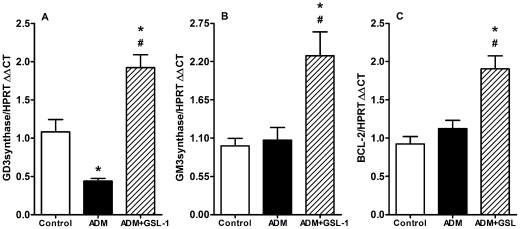
GSL-1 treatment induces transcripts for GM3 and GD3 synthases and the anti-apoptotic protein Bcl-2.BALB/c mice were injected at day 0 with 10 mg/kg of adriamycin (ADM) or treated concomitantly with ADM and 5 µg/mouse GSL-1 (ADM+GSL-1). (A) The ADM group showed decreased levels of ST8Sia1, the enzyme responsible for the generation of GD3 gangliosides, molecules that have been associated with podocyte physiology. In contrast, GSL-1 treatment increased the levels of this transcript compared with both control and ADM mice. (B) The levels of mRNA for GM3 synthase (ST3Gal5) were not altered in the ADM group; however, they were significantly augmented after GSL-1 treatment. Because GM3 gangliosides were associated with resistance to ADM-cytotoxicity due to Bcl-2 induction, we measured the mRNA levels of this protein in our system. (C) Bcl-2 transcripts were not altered by ADM but increased in ADM+GSL-1 mice, indicating a relationship between increased ST3Galt5 and Bcl-2 transcripts with renal protection from effects of ADM. * p<0.05 vs. control; # p<0.05 vs. ADM.